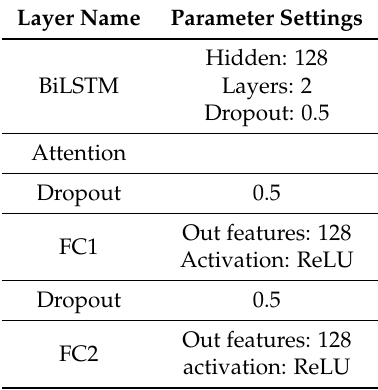
Table 2. Parameter settings of the BiLSTM model with an attention